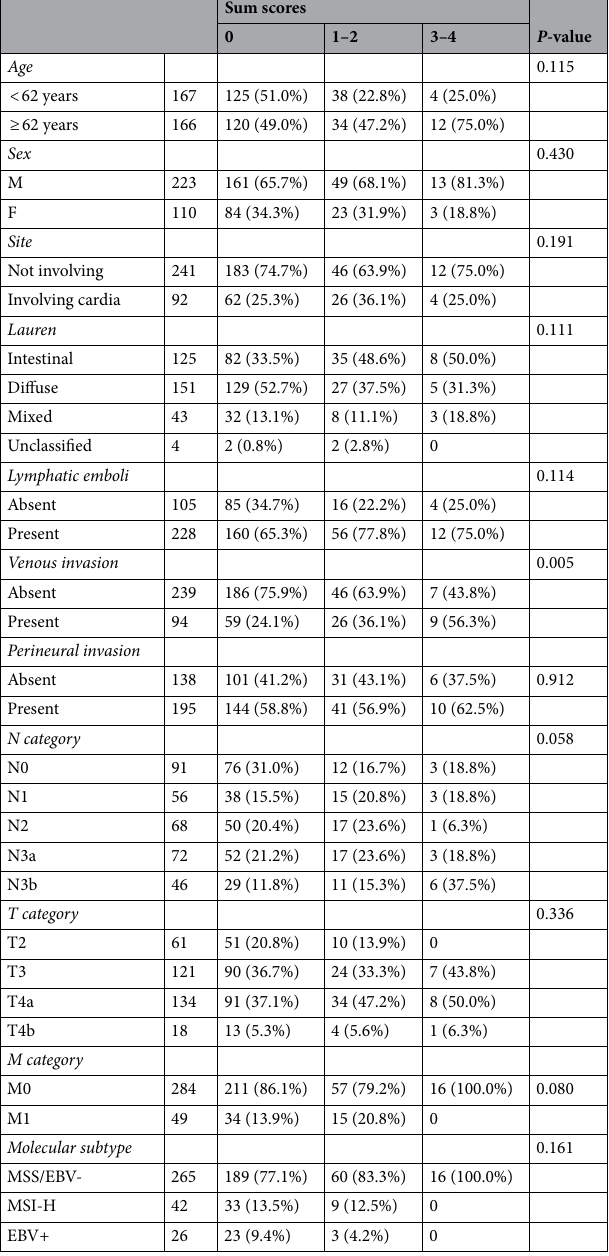
Table 3. Comparison of clinicopathological features according to the sum scores. Abbreviations: MSS, microsatellite-stable; EBV−, EBV-negative; MSI-H, high level of microsatellite instability; EBV+,